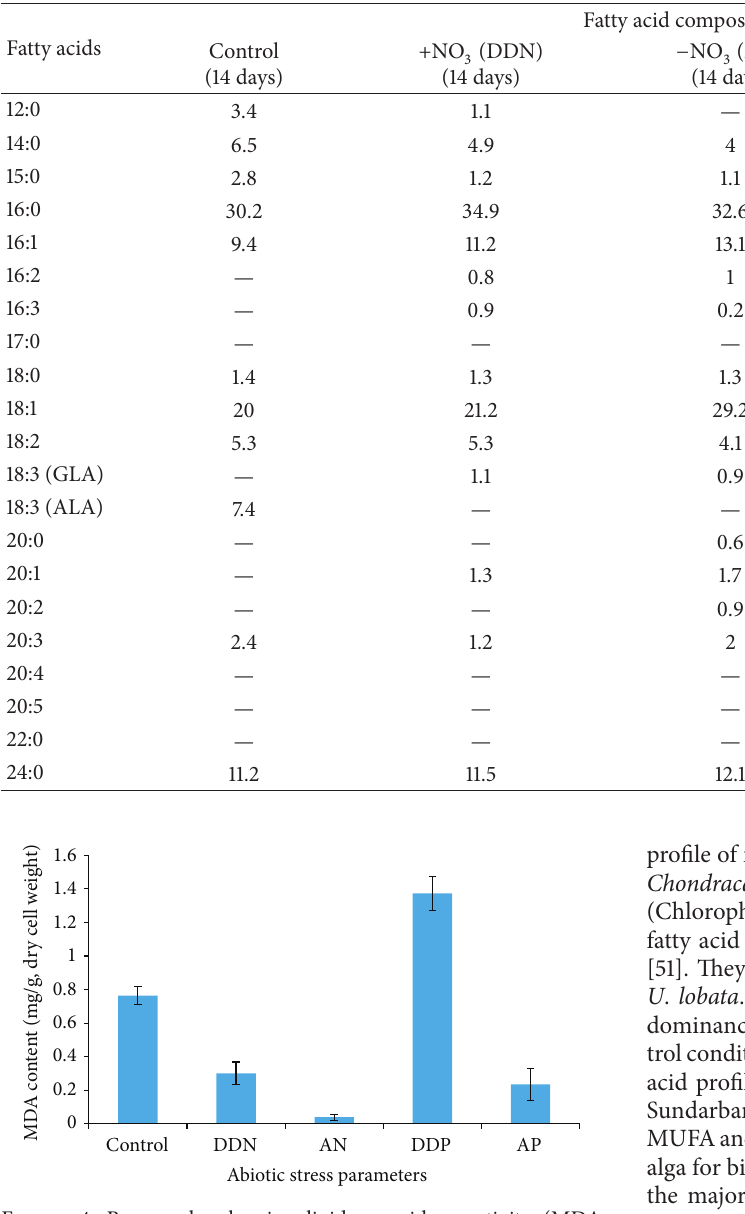
Figure 4: Bar graphs showing lipid peroxidase activity (MDA content) of both control and treated biomass (DDN, AN, DDP, and AP) of R . africanum . 𝑃 = probability value (significant level); 𝑃 ≤